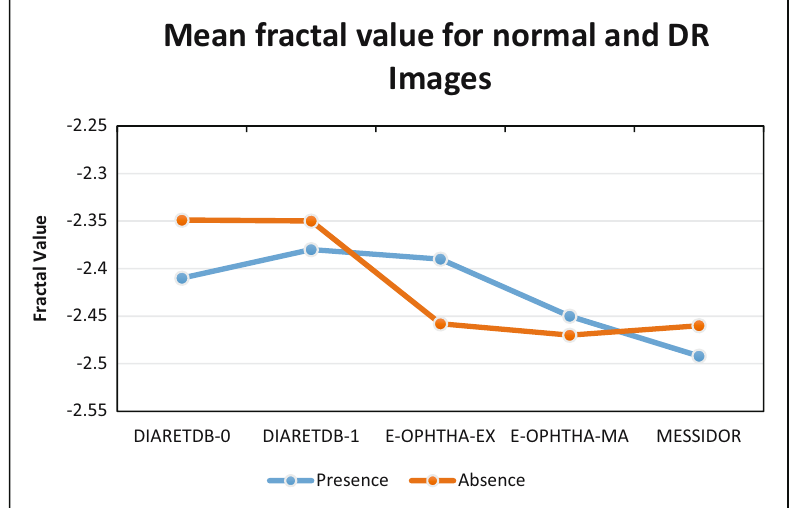
Figure 4: Mean fractal value for normal and DR